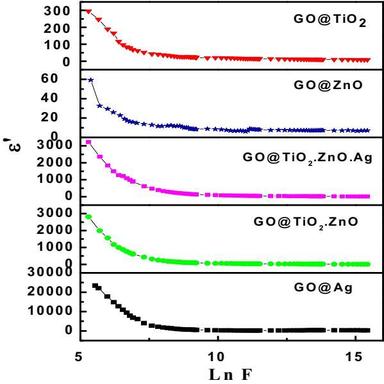
Dielectric permittivity (ε′ ) with applied AC frequency at room temperature RT.